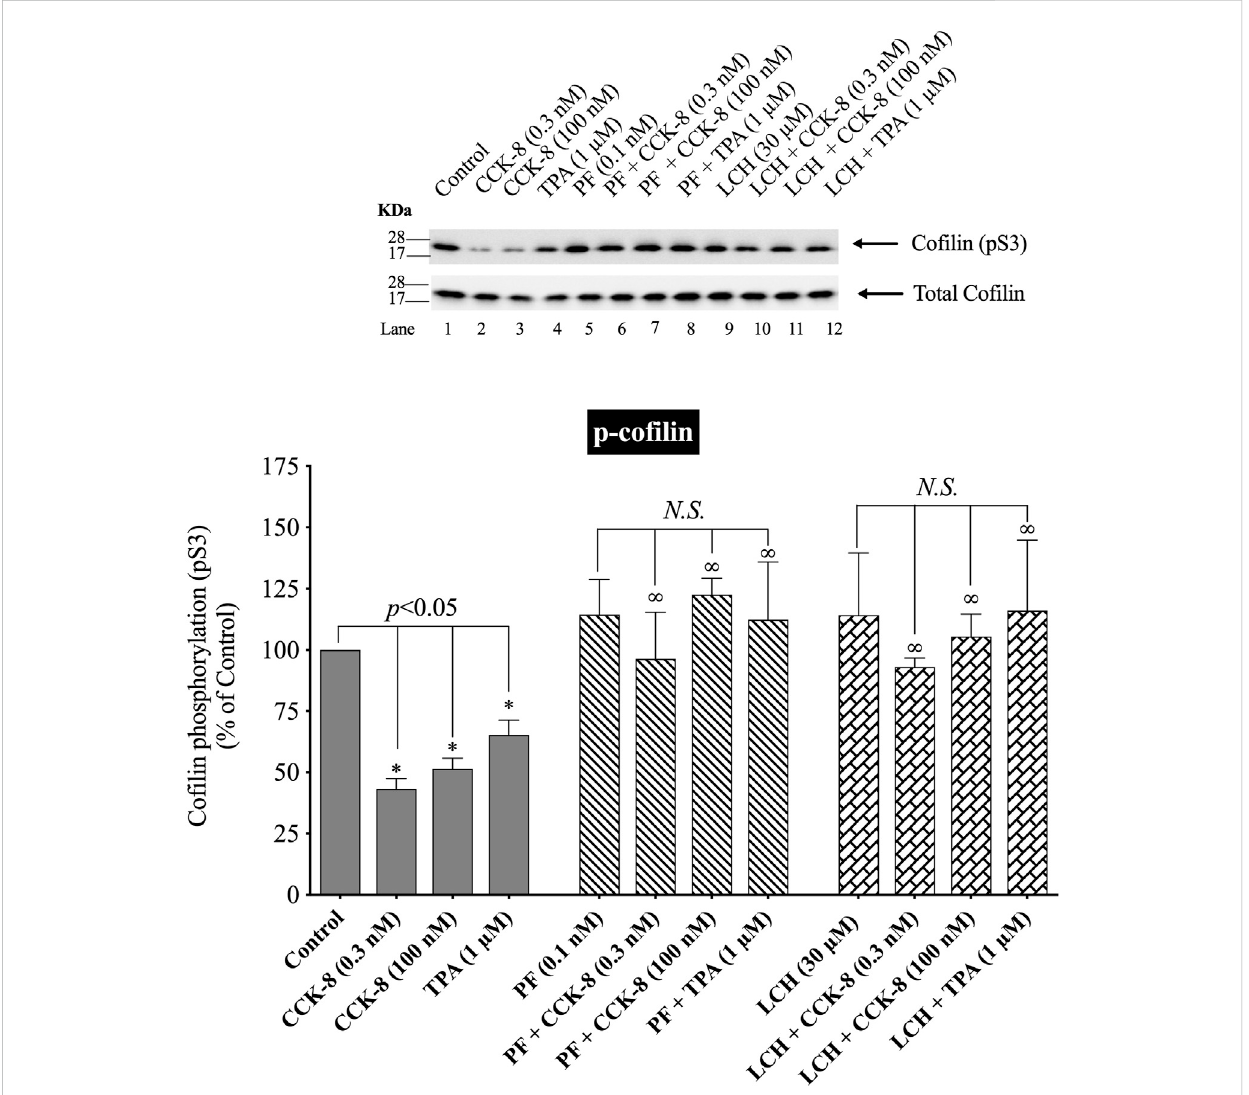
FIGURE 9 Effect of two PAK4 inhibitors, PF-3758309 or LCH-7749944, on the ability of CCK-8 (0.3 and 100 nM) or TPA (1 µM) to alter activation of co fi lin. IsolatedpancreaticaciniwereincubatedintheabsenceorpresenceofPF-3758309(0.1 nM)orLCH-7749944(30 µM)for3 handthenincubatedwithno additions (control), CCK-8 (0.3 and 100 nM) for 3 min or TPA (1 µM) for 5 min, and then lysed. Western blots were analyzed using anti-pS3 co fi lin. Bands werevisualizedusingchemiluminescenceandquanti fi edbydensitometry. Top :Resultsofarepresentativeblotoffourindependentexperimentsare shown. Bottom : Means ± S.E. of at least 4 independent experiments. Results are expressed as % of basal stimulation of the control group. *, p < 0.05 compared to the control group; ∞ , p < 0.05 compared to stimulants without inhibitors; N.S. , No signi fi